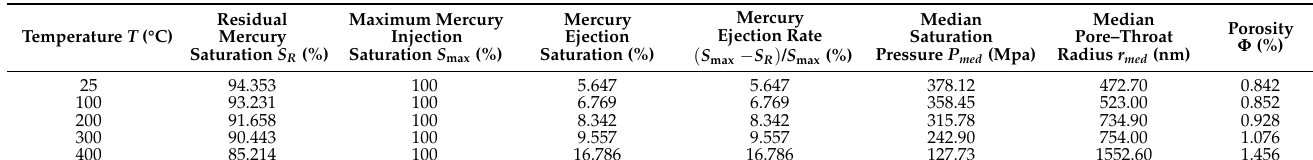
Table 1. Experimental results.